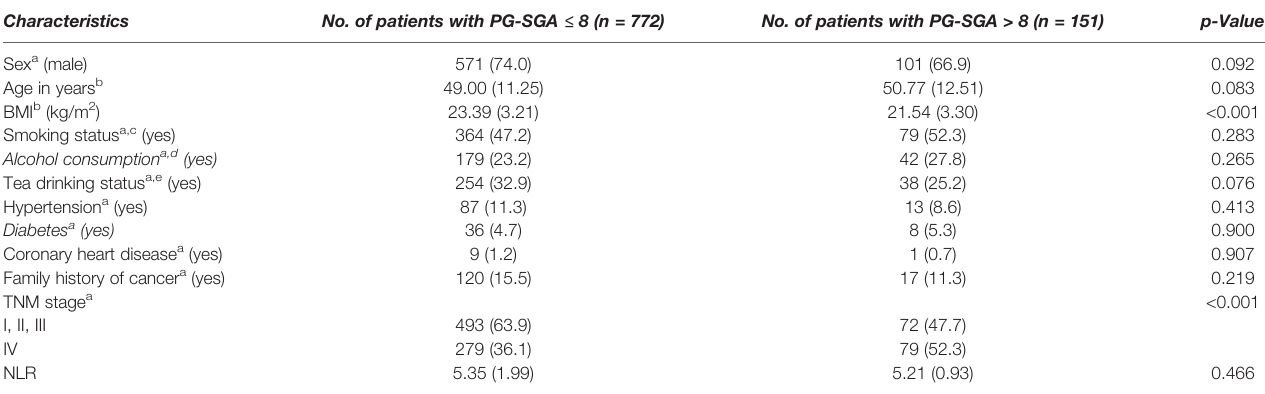
TABLE 1 | Demographic and clinical characteristics of patients with NPC undergoing chemoradiotherapy strati fi ed by PG-SGA. Characteristics